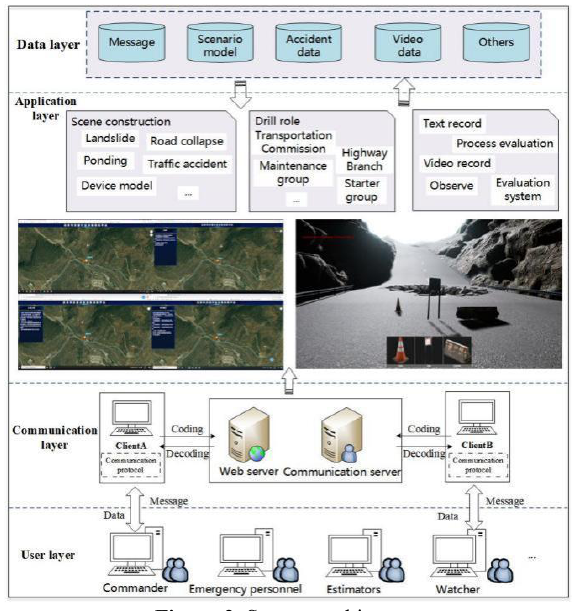
Figure 1. Mechanism of HTTP and Websocket Figure 2. System